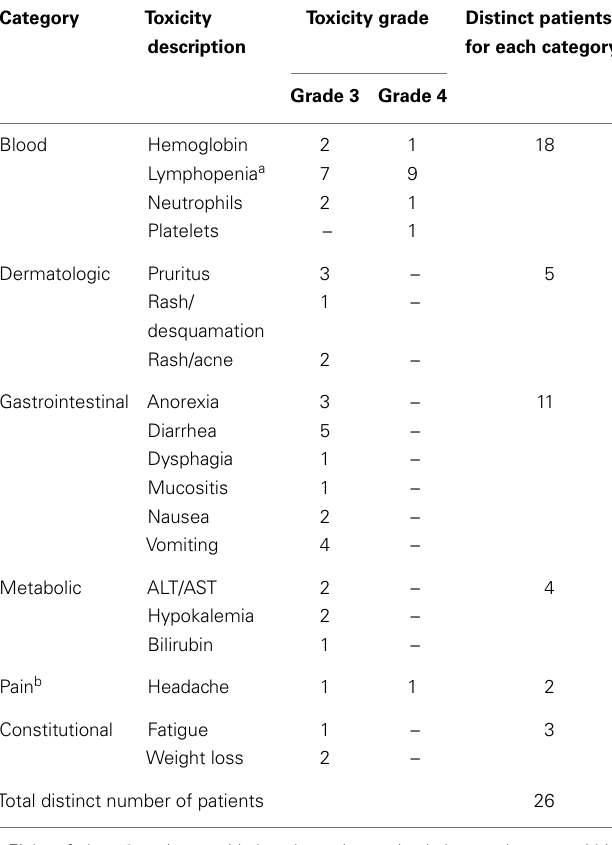
Table 3 |Toxicity profiles of the study cohort irrespective of attribution to